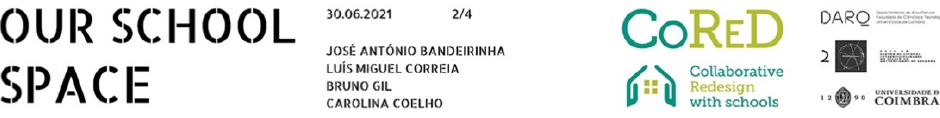
Figure 9. Design proposal for the new entrance and refurbishment of the outdoor spaces of Escola Básica Rainha Santa Isabel (EBRS)—edited from the original panel presented at the School Assembly.